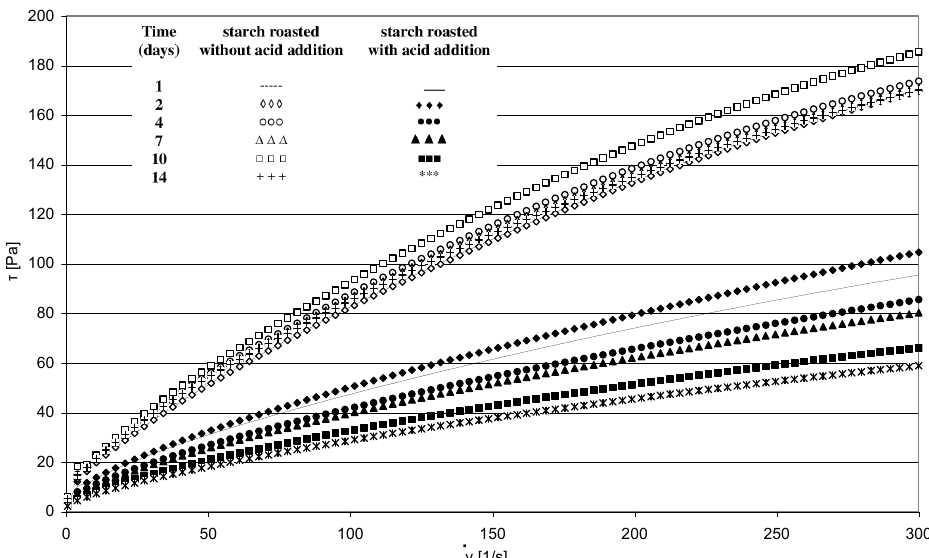
Figure 6. Flow curves of pastes produced from starch retained for various periods of time with and without citric acid.